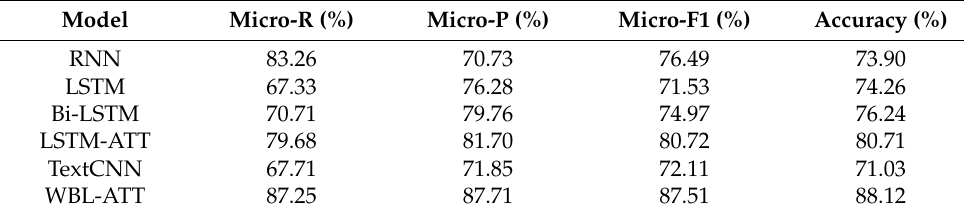
Table 7. Model evaluation results.